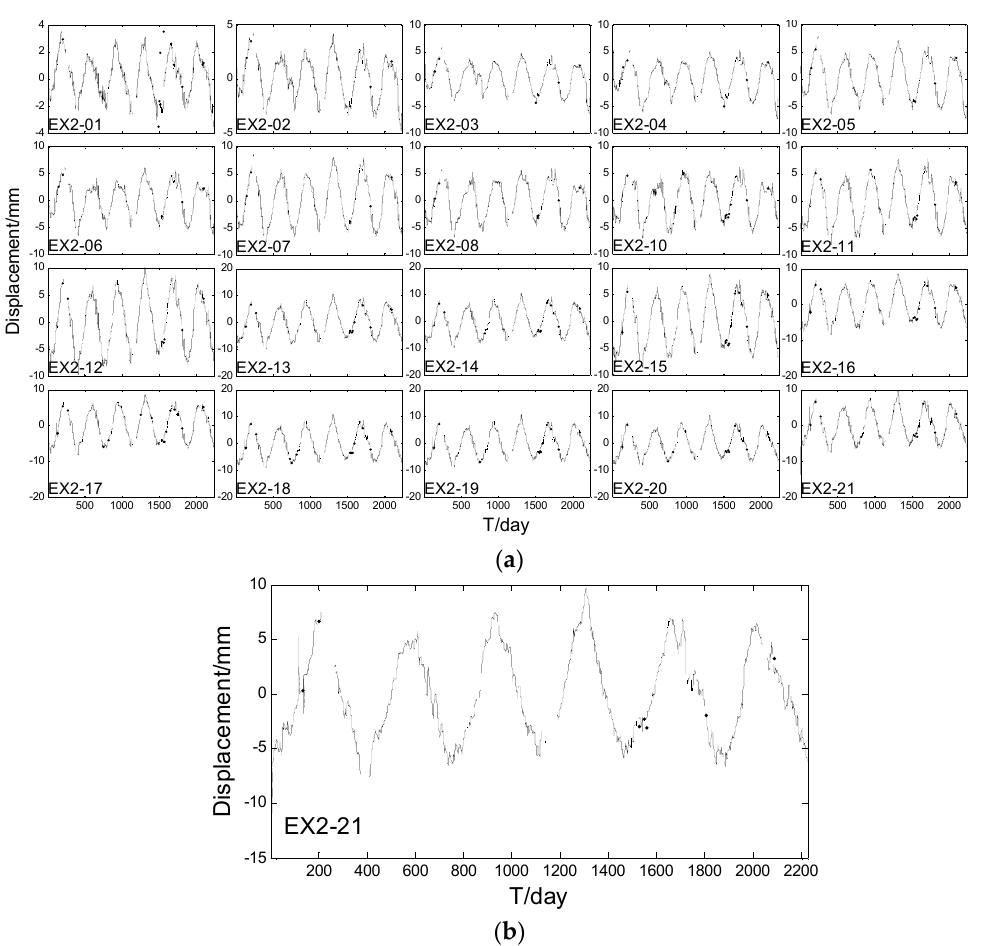
Figure 4. Displacement sequences. ( a ) Displacement sequence of the 20 points; ( b ) Displacement sequence of EX2_21. Table 2. Position information of EX2 tension wire alignment measuring points (unit: m).